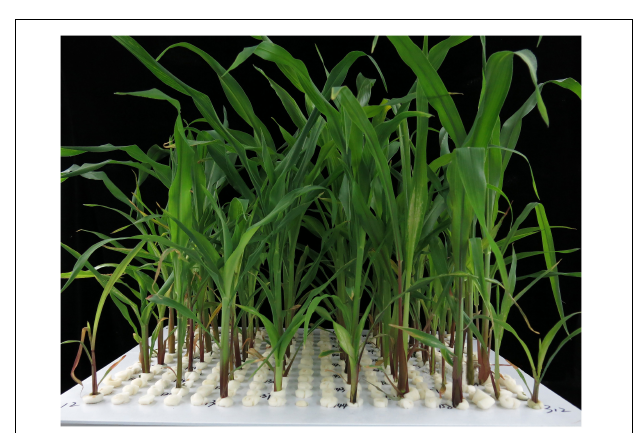
FIGURE 6 | Phenotypic variation in the recombinant inbred line (RIL) population. In the -Zn treatment (0.3 µ mol L − 1 Zn-EDTA), two plants for each parent and 55 RILs were grown in hydroponics for 21 days after transplanting in each tank. Large phenotypic variations of Zn-deficient symptoms were observed among RILs under Zn deficiency.